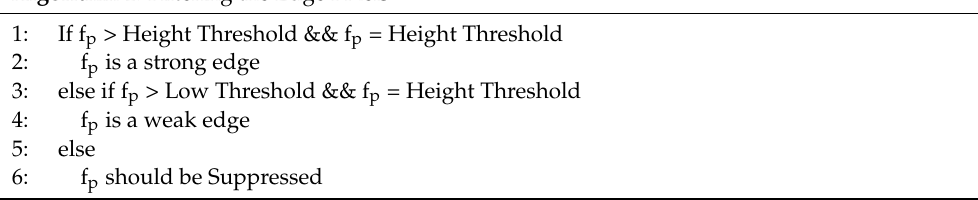
Algorithm 1 : Filtering the Edge Pixels